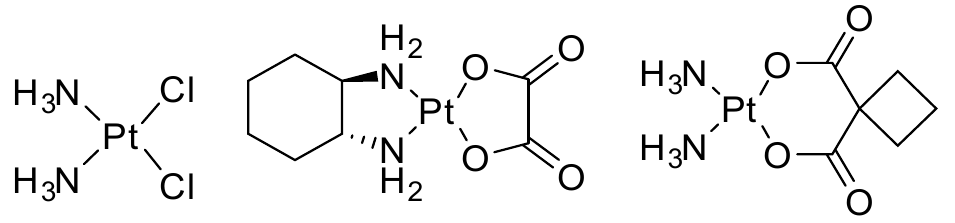
Figure 1. The structures of cisplatin ( left ), oxaliplatin ( middle ), and carboplatin ( right ). The leaving groups in these complexes are anions of dicarboxylic acids. Bidentate dicarboxylates are a good alternative to chloride ions. Such ligands increase both the water solubility and lipophilicity of the complexes, and the chelating effect increases the stability of compounds in the bloodstream and reduces the number of side effects. In order to change the activity profile and the lipophilicity and reduce systemic